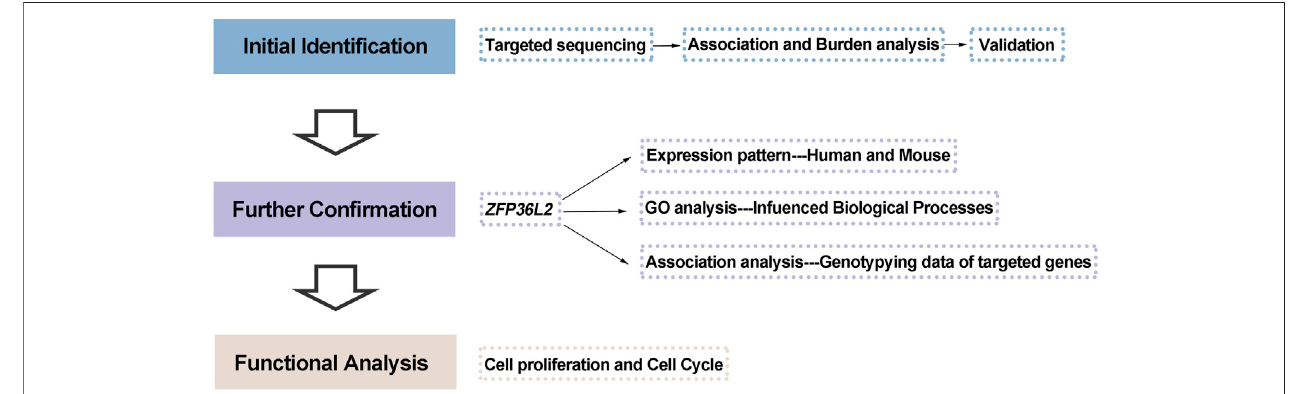
FIGURE 1 | Details of the study